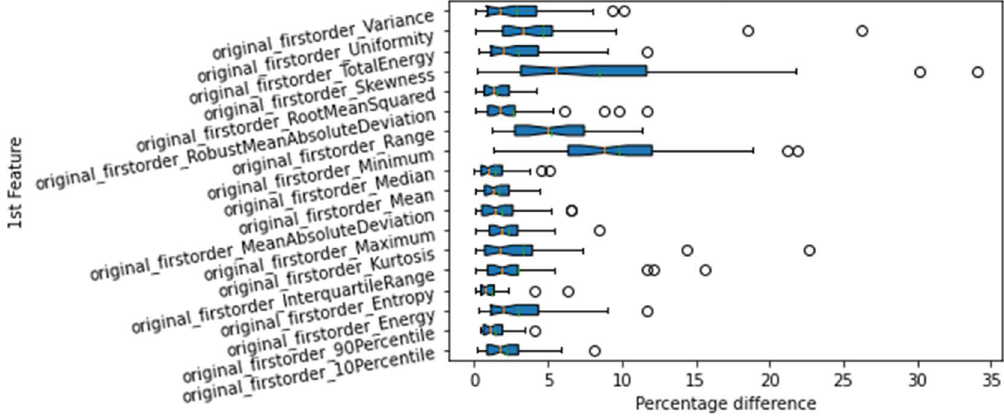
Figure 2. Difference percentage between non-co-registered and co-registered PET with T1-weighted and FLAIR MRI (the median is indicated in orange, while mean in green) for shape-based features.